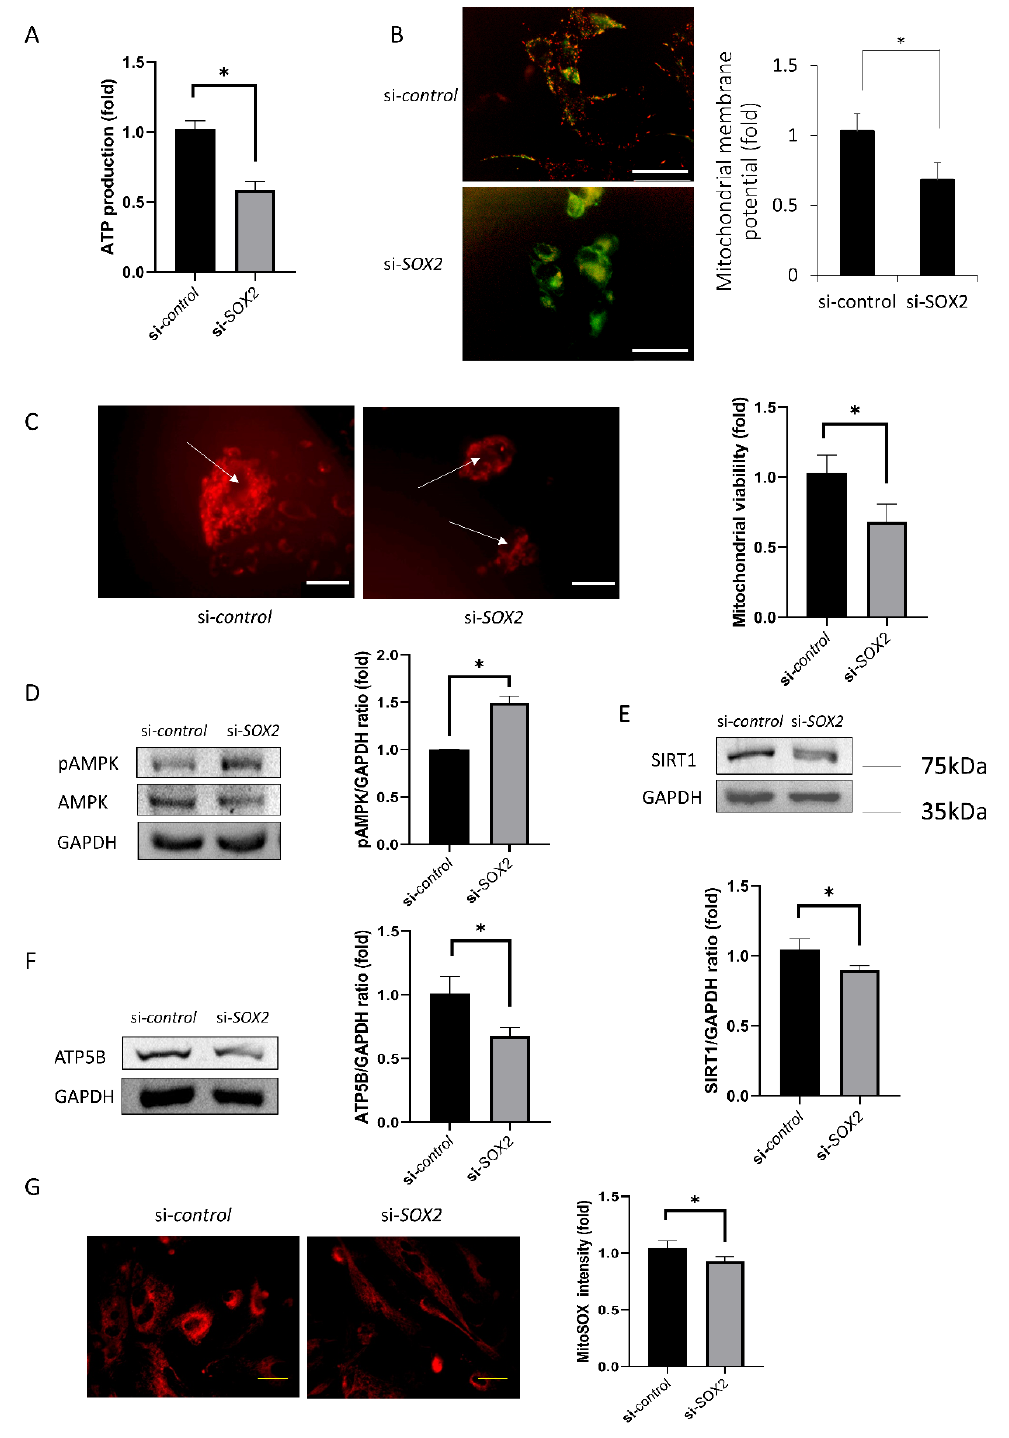
Figure 4. Mitochondrial functions. ( A ) Energy production in hCECs. ( B ) Mitochondrial membrane potential using the JC-1 probe. Scale bar denotes 100 µ m. ( C ) Mitochondrial viability. Scale bar denotes 75 µ m. Arrows indicating nuclei. ( D ) pAMPK level. ( E ) SIRT1 level. ( F ) ATP5B amount was lower in si -SOX2 -transfected cells. Graph provides the results from triple experiments. ( G ) Mitochondrial oxidative stress levels by MitoSOX fluorescence intensity. Scale bar denotes 50 µ m. * indicates statistical significance by independent t -test.